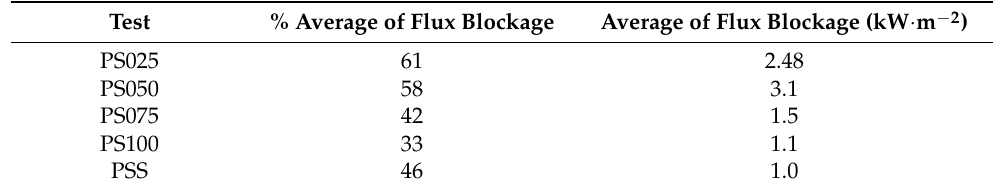
Table 3. Average of heat flux